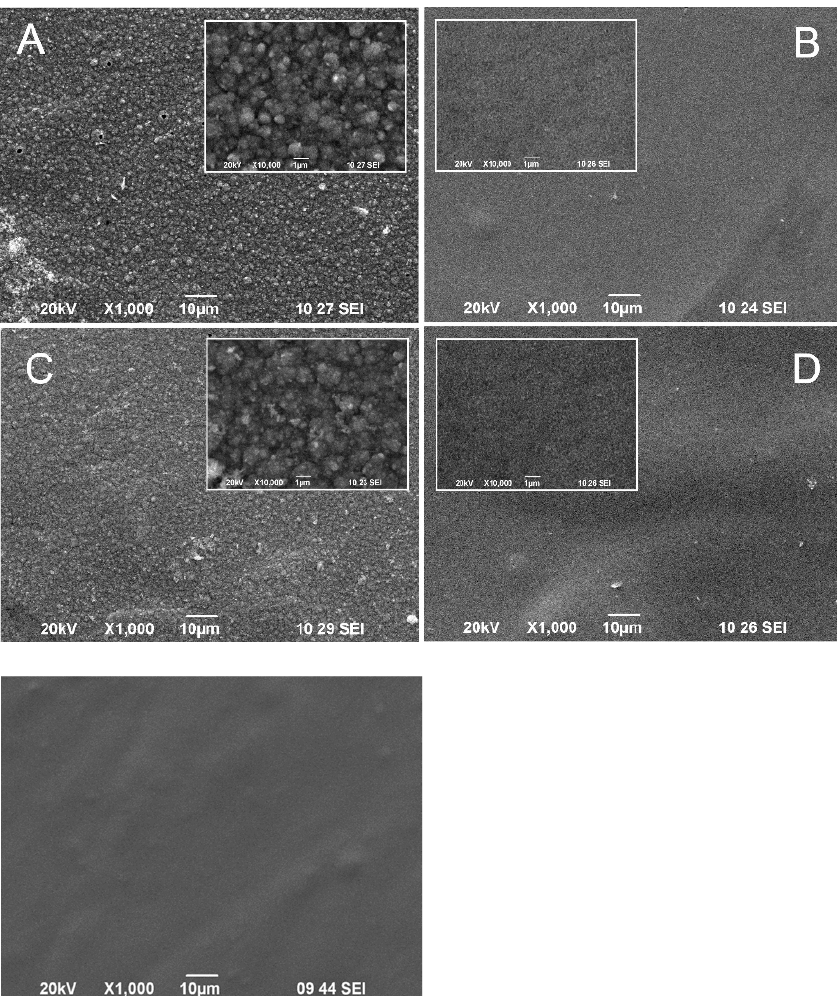
Figure 4. SEM images of CuO nanoparticles on a zinc surface ( A ) and of hybrid zinc coating with incorporated CuO nanoparticles ( B ); CuO based nanocontainers with Safranin on zinc surface ( C ) and of hybrid zinc coating ( D ) with incorporated nanocontainers with the corrosion inhibitor; ordinary zinc coating (bellow) . Magnification of the insets–×10,000